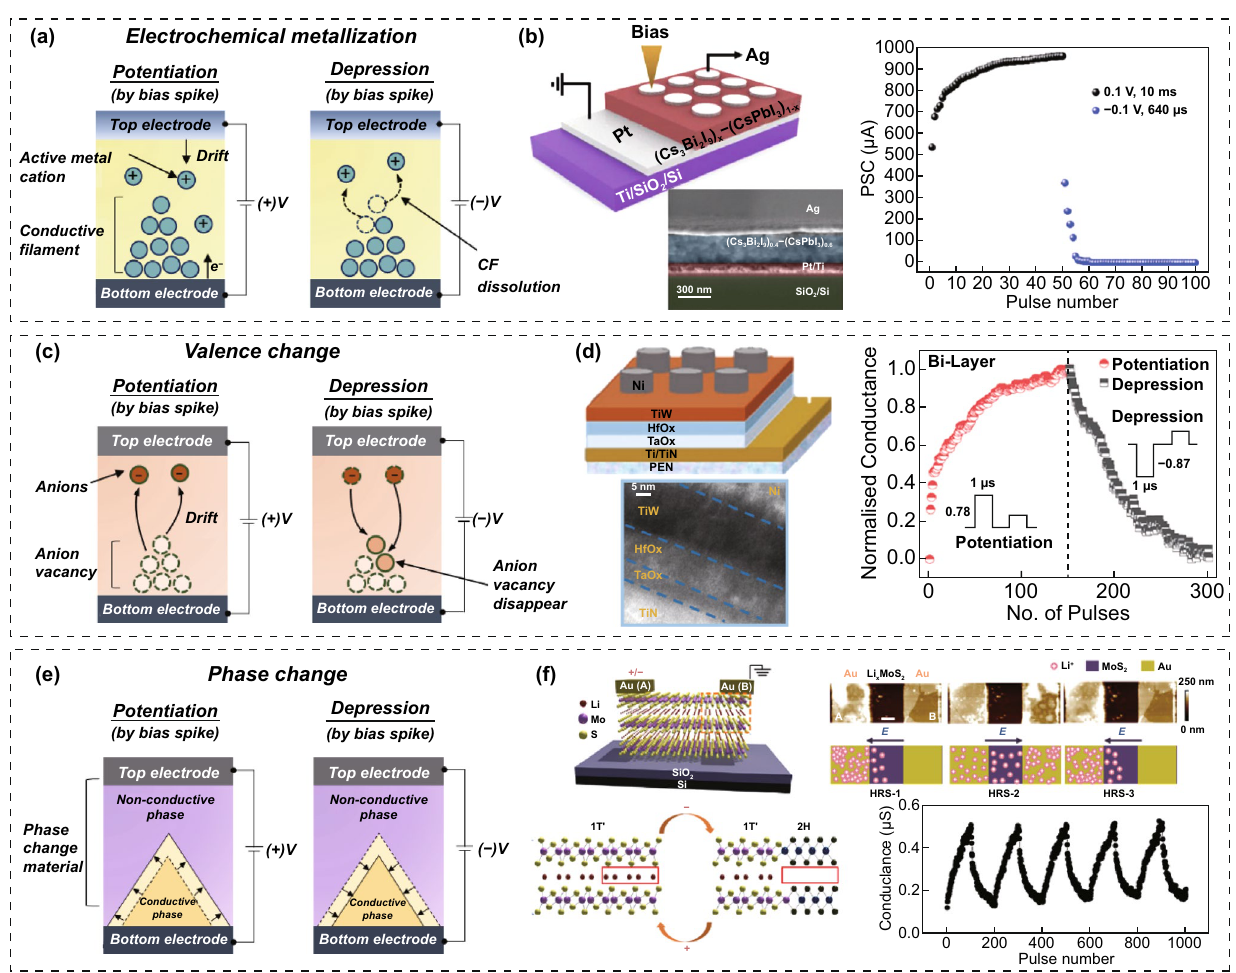
Fig. 6 Memristor‑type ESs; device configuration, operation mechanism, and electrical conductance switching performance. a , b electrochemi‑ cal metallization (ECM) memristor‑type ES: a operation mechanism and b perovskite‑based ECM memristor‑type ES. c , d valence change (VC) memristor‑type ES: c operation mechanism and d oxide‑based VC memristor‑type ES. e , f phase change (PC) memristor‑type ES: e operation mechanism and f Transition‑metal dichalcogenide (TMDC)‑based memristor‑type ES. b Reproduced with permission from Ref. [41].